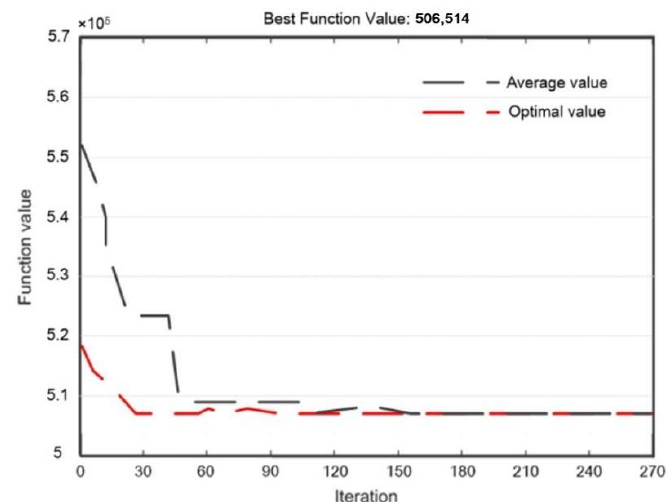
Figure 12. Schematic diagram of the genetic algorithm iterations.